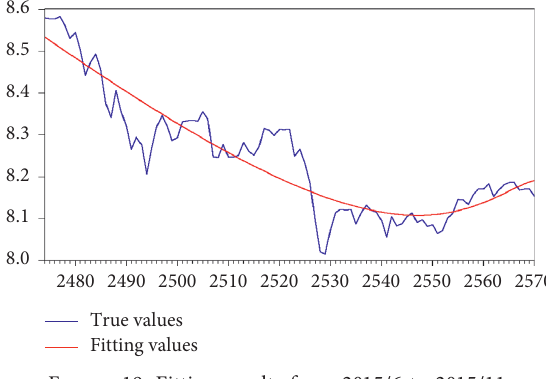
Figure 19: Fitting results from 2015/6 to 2015/11.